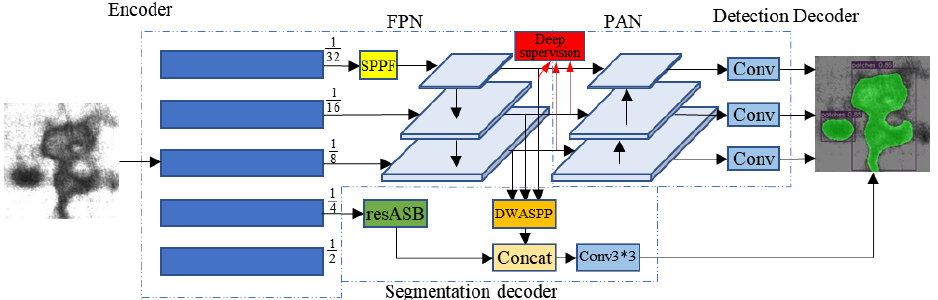
Figure 2. Architecture of the proposed model.